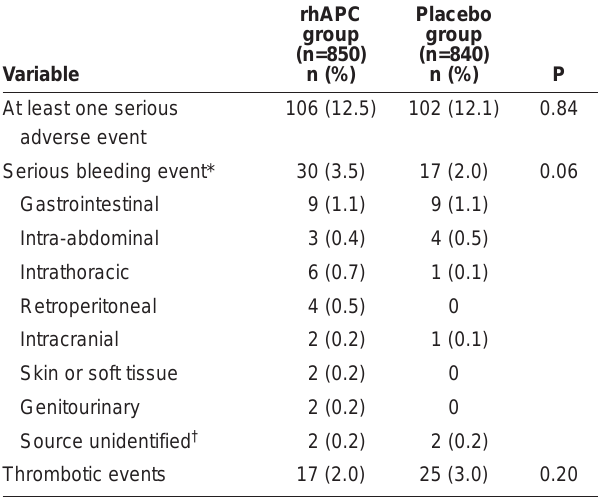
TABLE 6 PROWESS trial data with recombinant human activated protein C (rhAPC) treatment: Mortality in patients